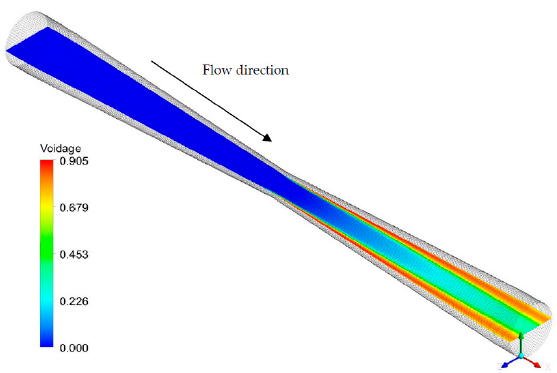
Figure 7. Distribution of the steam volume fraction inside the nozzle.